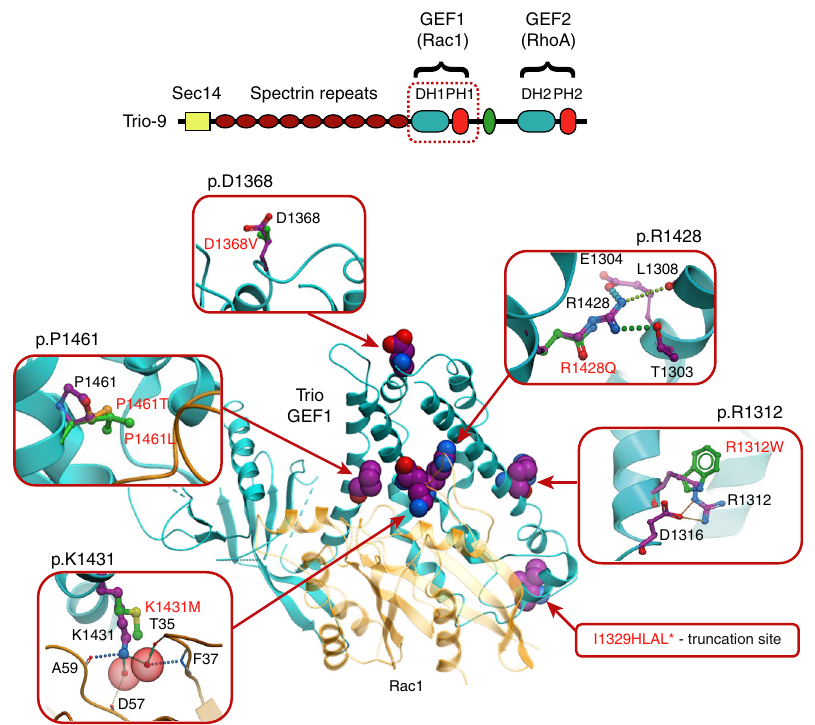
Fig. 3 Predicted effects of ASD-related DH1 mutations on Rac1 activation. The GEF1 domain in the context of the entire protein is shown above with the GEF1 domain identi fi ed by a dashed red square . An overall view of the Trio-GEF1 and Rac1 complex structure is shown beneath, with the two interacting proteins shown as blue and orange cartoons, respectively (Protein Data Bank code 2NZ8). Amino-acid residues mutated in ASD-related disease are shown as spheres with carbon atoms colored magenta . Zoomed in inserts represent interactions between amino-acid residues in wild-type and mutant protein. Wild-type residues are labeled and shown in stick representation, with carbon atoms colored in magenta . Mutated amino acids are shown with carbon atoms colored green or yellow . Hydrogen bonds/salt bridges are shown as dashed lines . Water molecules involved in GEF1-Rac1 interactions are indicated by transparent red